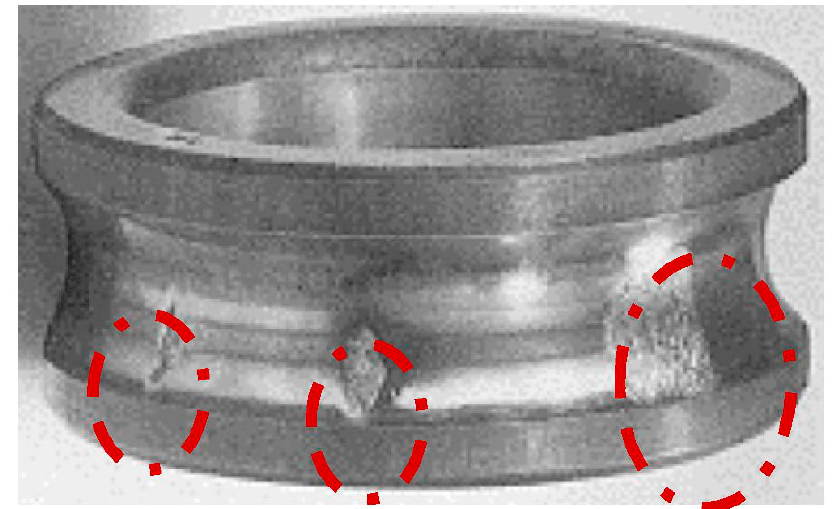
Figure 5. Degradation shells of a deep-groove ball